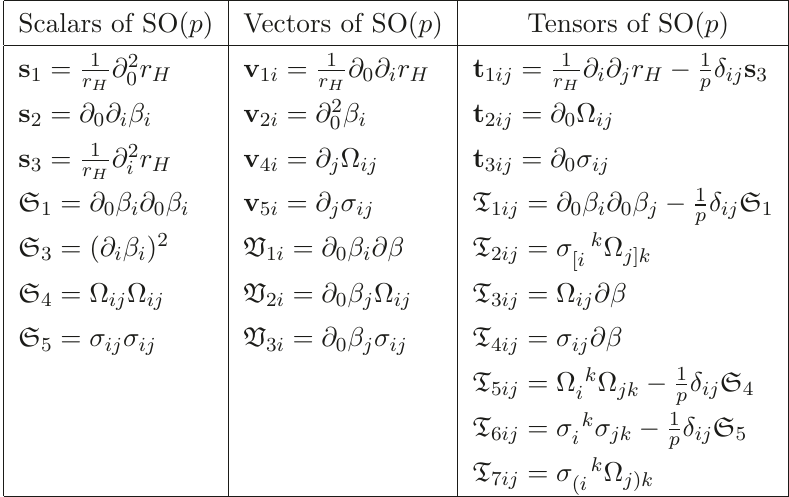
2. T 2 , 5 , 6 are zero ≥